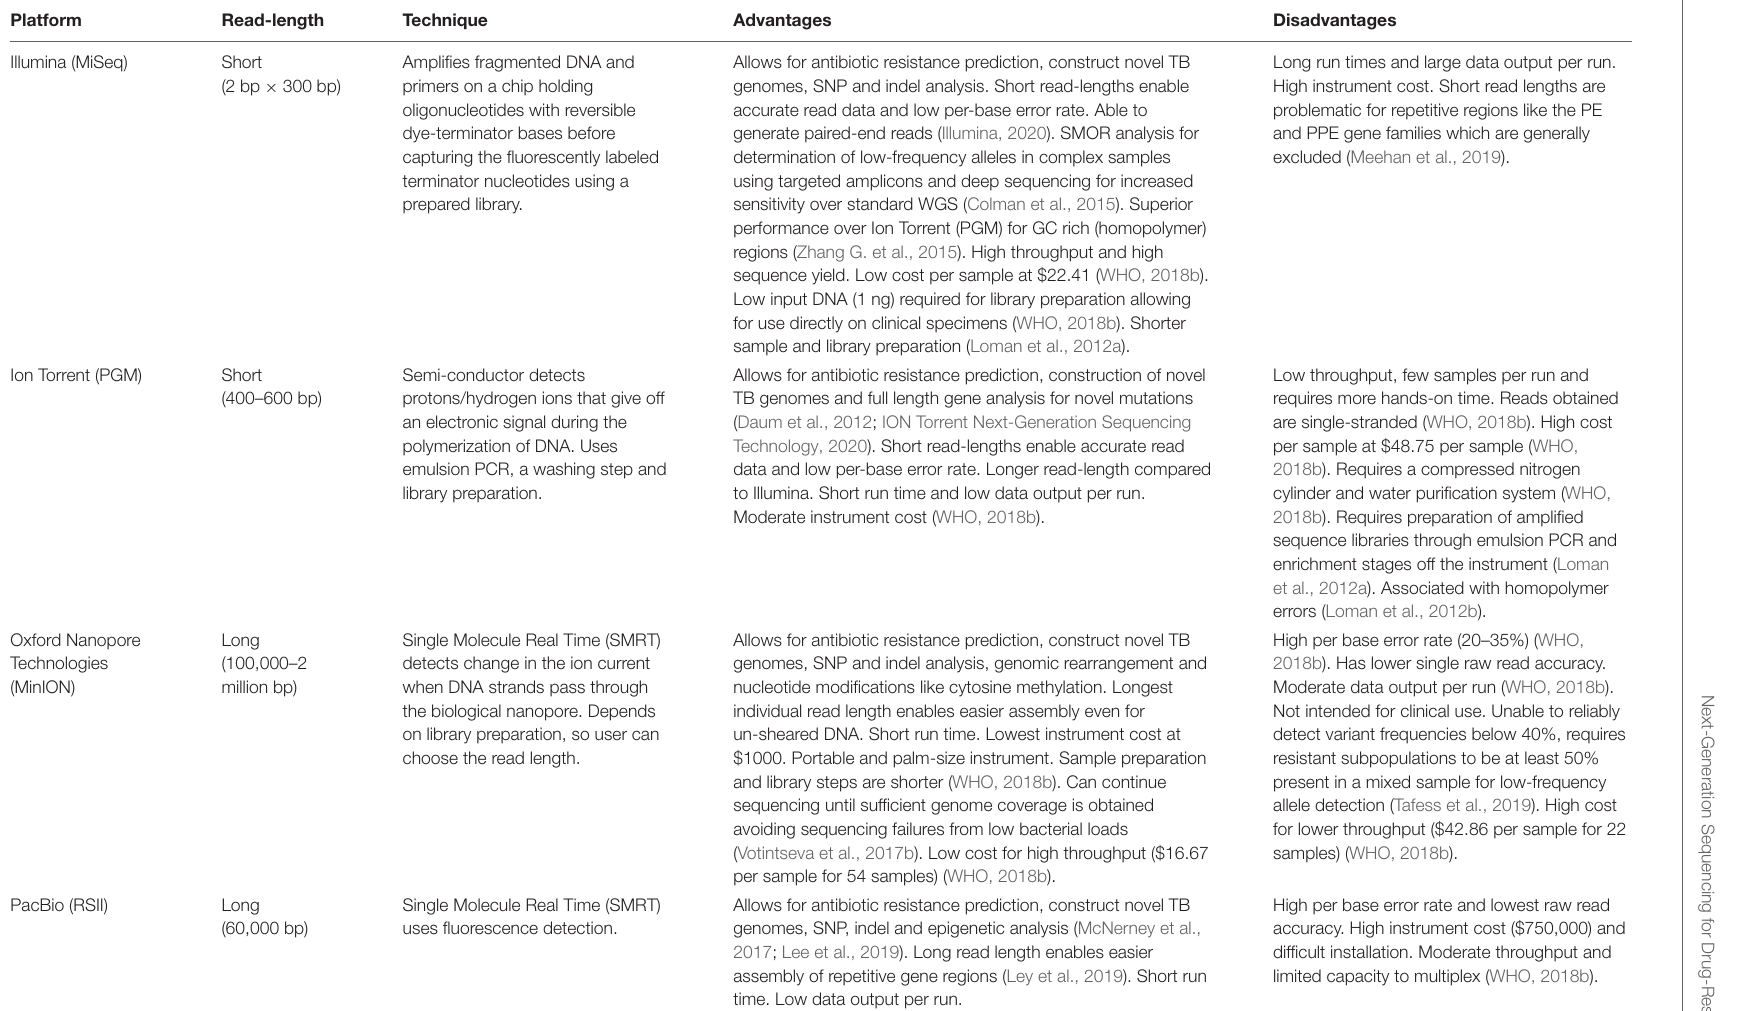
TABLE 1 | Advantages and disadvantages of whole genome sequencing platforms. Platform